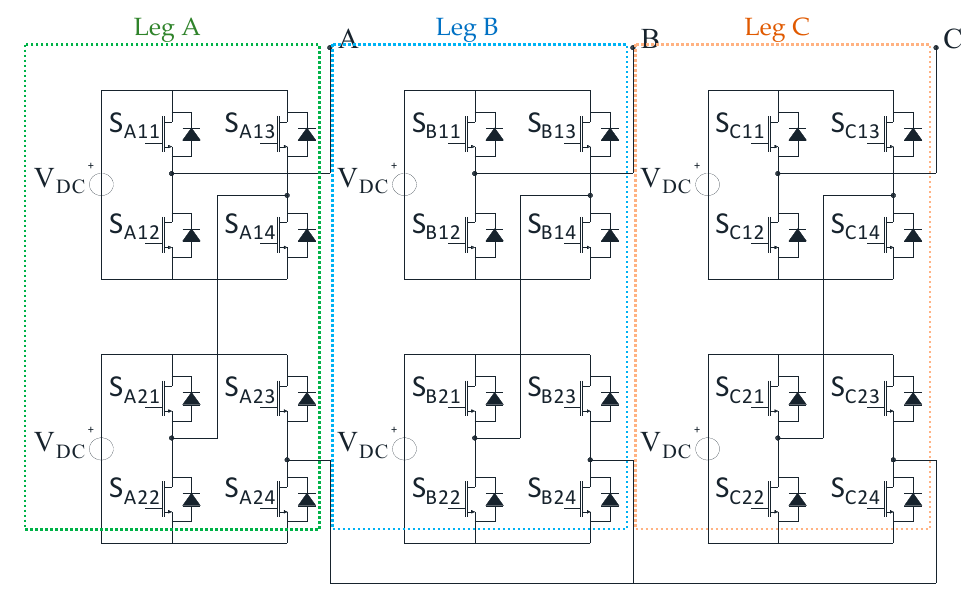
Figure 1. Circuit diagram of a three ‐ phase five ‐ level CHB.